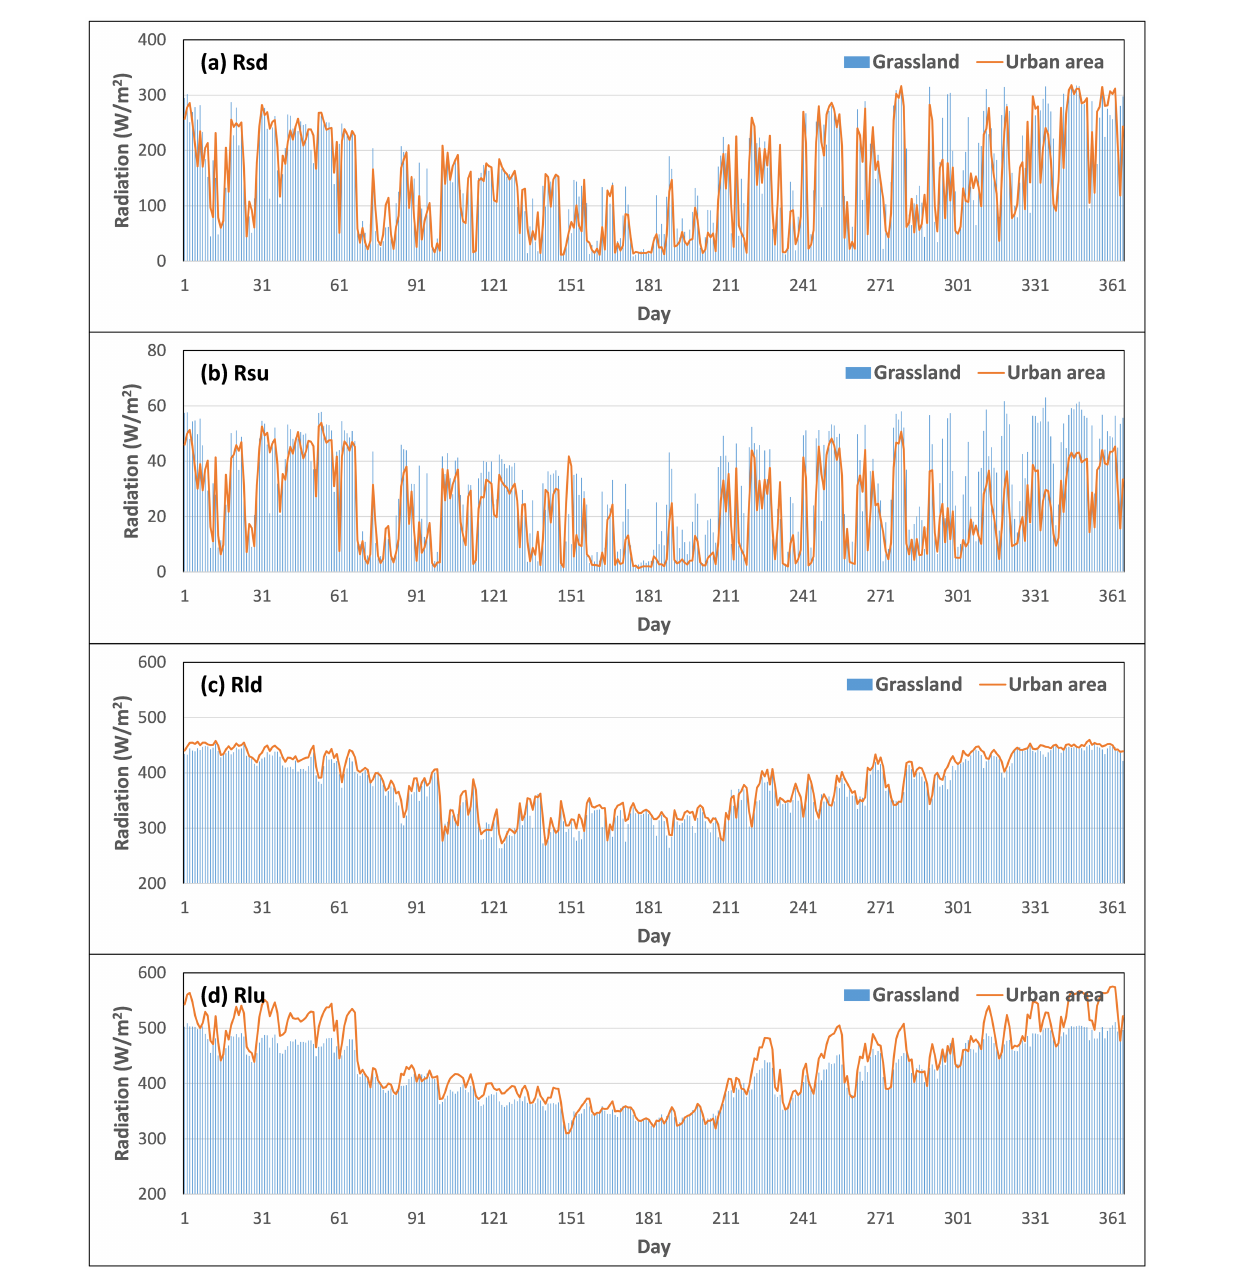
FIGURE 2 Temporal variations of surface radiation of (A) Rsd, (B) Rsu, (C) Rld, (D) Rlu in grassland and urban areas from Aug 1st in 2021 to July 31st in